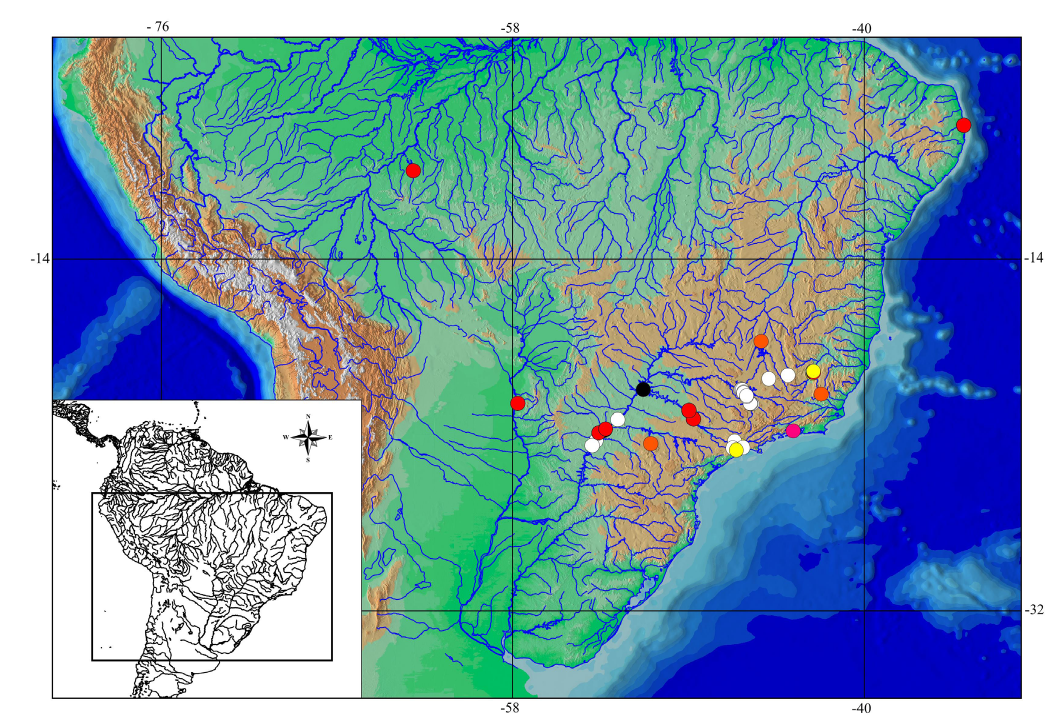
Figure 1. Examples of non-native zooplankton introduced in different Brazilian environments: Ceriodaphnia dubia , yellow circle; Daphnia lumholtzi , black circle; Kellicottia bostoniensis , white circle; Lamproglena monodi , pink circle; Lernaea cyprinacea , orange circle; Mesocyclops ogunnus , red circle (Sampling sites; see Table